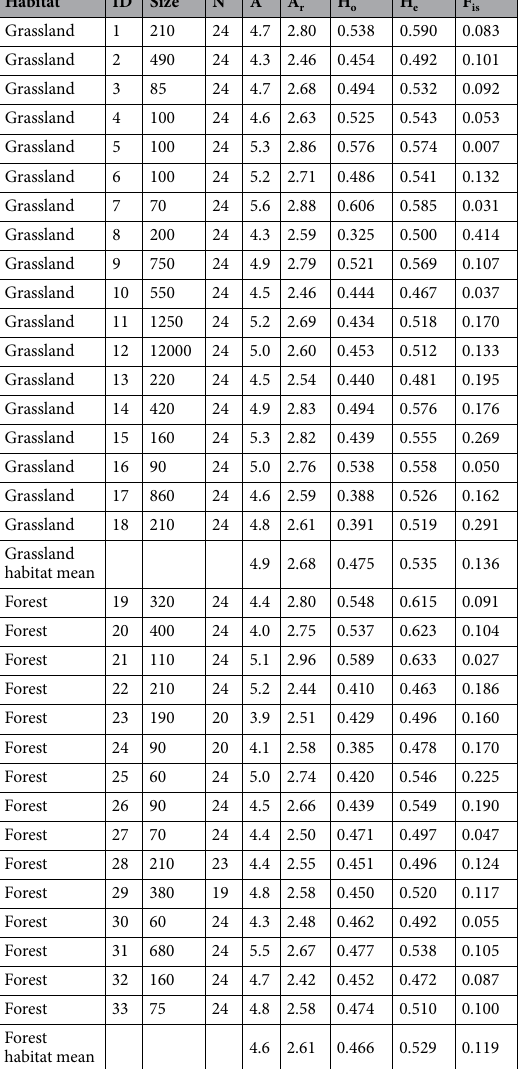
Table 1. Genetic diversity measures for all sampled P. veris populations among the two habitats. Size, number of flowering individuals; N, number of sampled individuals; A, number of alleles per locus; A r , allelic richness; H o , observed heterozygosity, H e , expected heterozygosity; F is , inbreeding coefficient. The mean value of every genetic measure is given for each habitat.